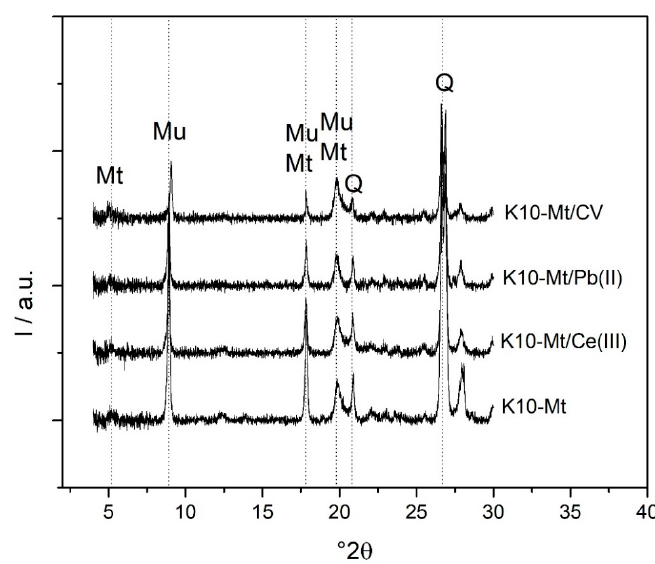
Figure 9. XRD patterns of pristine K10-Mt and K10-Mt / pollutants complexes. Montmorillonite (Mt), muscovite (Mu), quartz (Q).